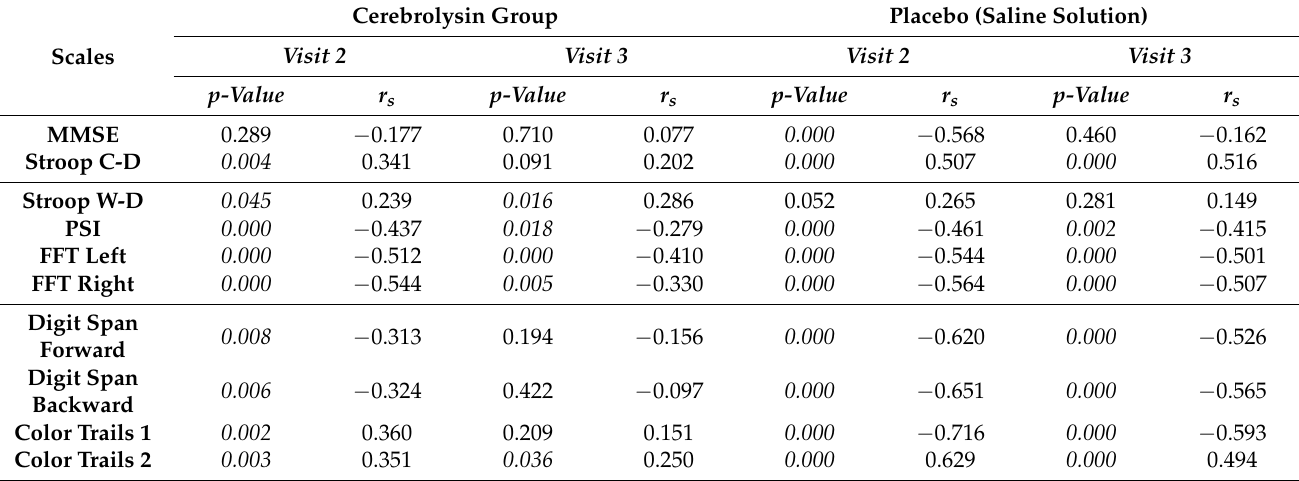
Figure 4. HADS-Depression score distribution for the treatment and placebo groups for the third visit. Correlations of HADS-Anxiety and -Depression subscales with other neuropsycho- logical scales are presented in Tables 6 and 7. Statistically significant negative correlations at the third study visit are reported between HADS-Anxiety and FFT (Left and Right), PSI, and Digit Span Forward and a statistically significant positive correlation between HADS-Anxiety and CCT2, Stroop W-D, PSI, and MMSE. Table 6. Correlations with HADS-Anxiety.